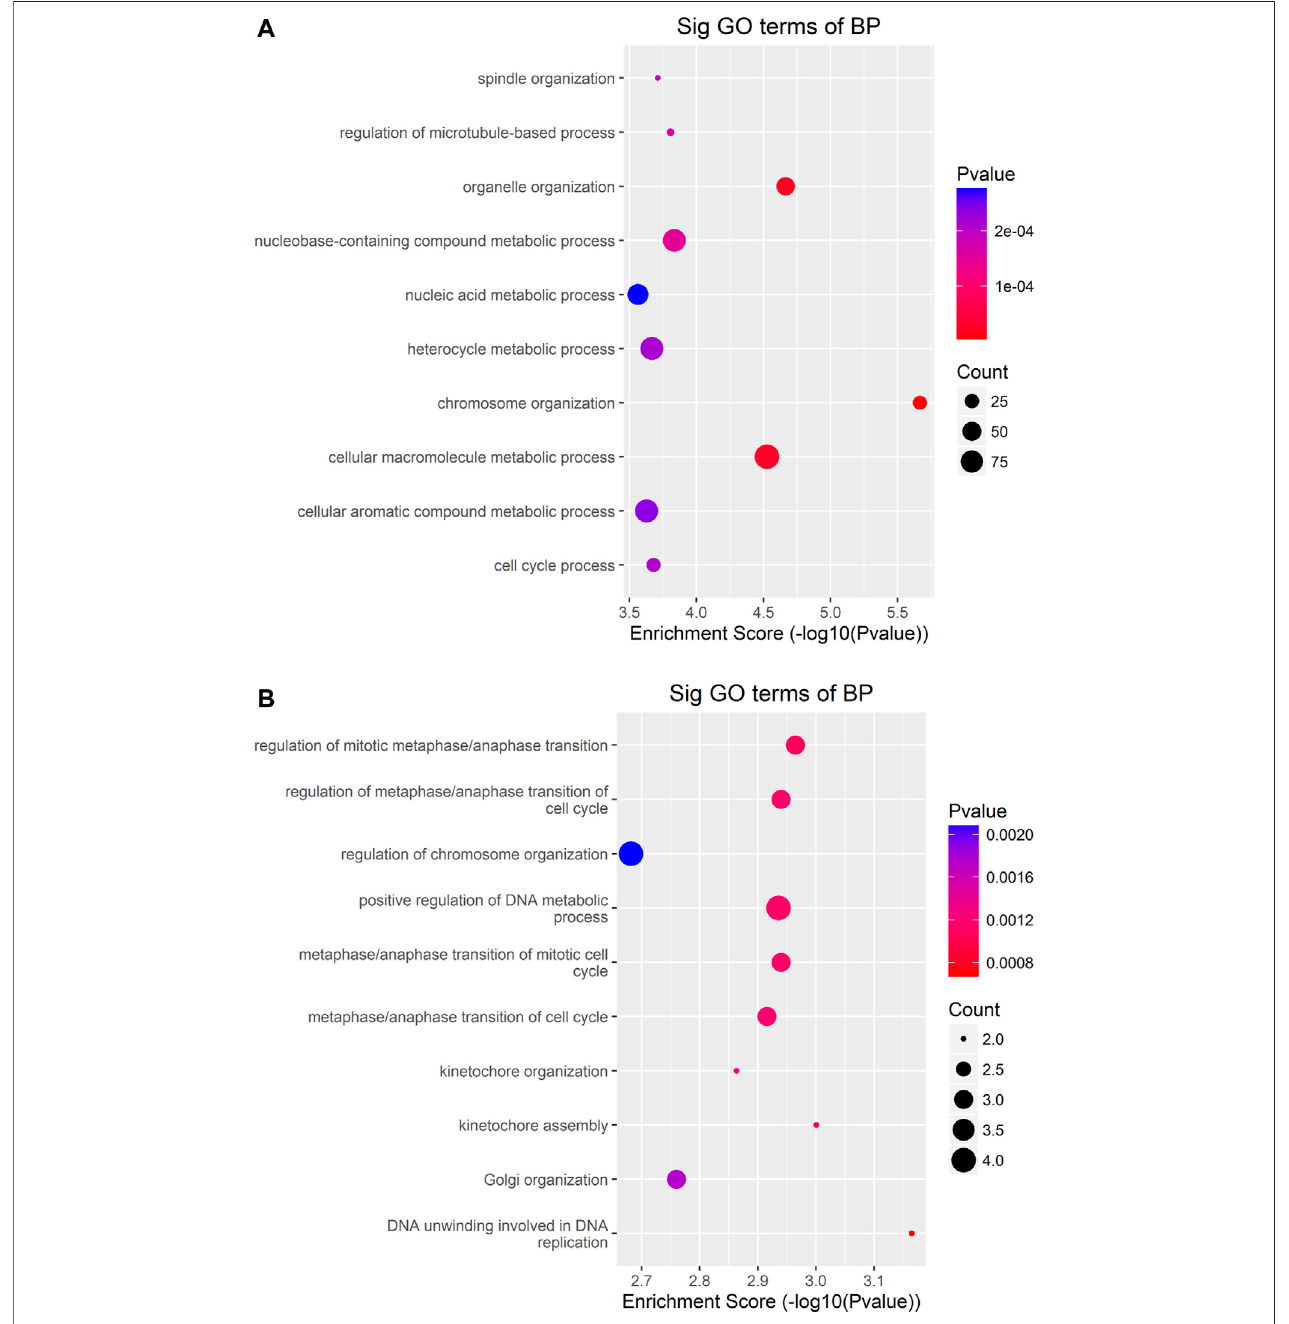
FIGURE5| GO-enrichmentanalysisfordifferentiallymethylatedmRNAs (A) Thetoptengeneontologytermsofbiologicalprocessesweresigni fi cantlyenrichedfor the up-methylated genes. (B) The top ten gene ontology terms of biological process signi fi cantly enriched for down-methylated genes.